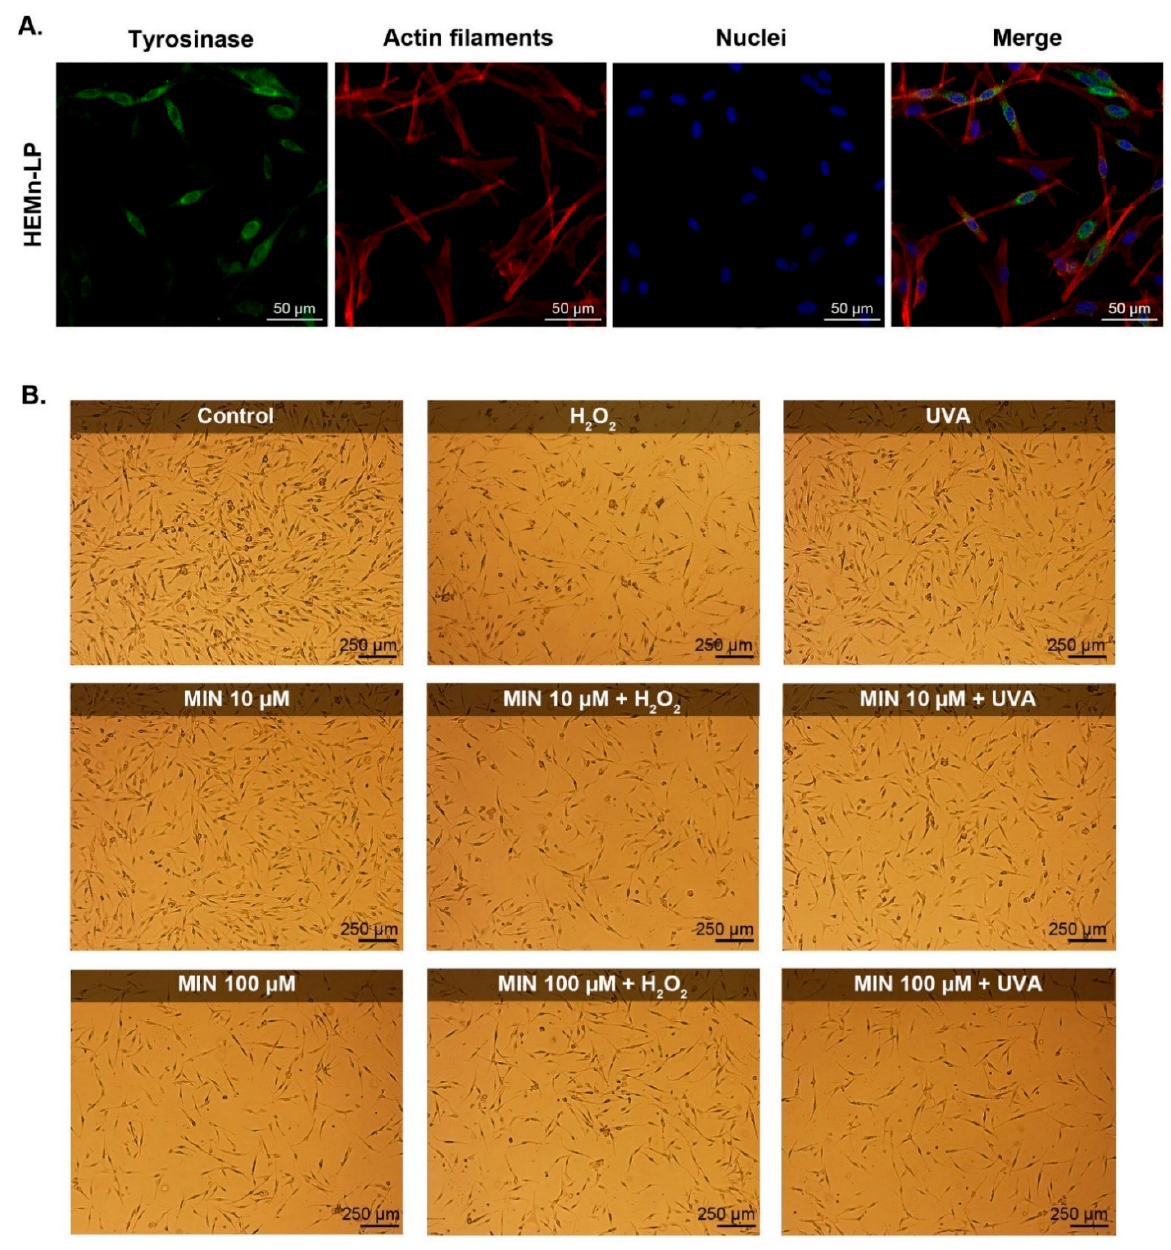
Figure 2. Microscopic evaluation of HEMn-LP cell line. Confocal microscopy imaging of the cells: tyrosinase, actin filaments, and nuclei were stained with anti-tyrosinase primary antibody and Alexa Fluor 488-conjugated secondary antibody, Phalloidin–Atto 565, and DAPI, respectively. Photographs are presented as separate channel as well as a merge image. Scale bar 50 µ m ( A ). Microscopic photographs of human normal melanocytes, lightly pigmented exposed to minocycline, hydrogen peroxide, and UVA radiation. Scale bar 250 µ m ( B ).